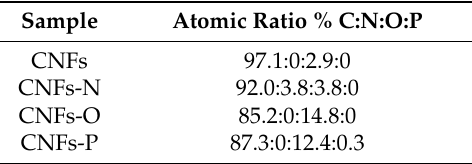
Table 1. C:N:O:P Atomic ratio calculated by XPS analysis of the various